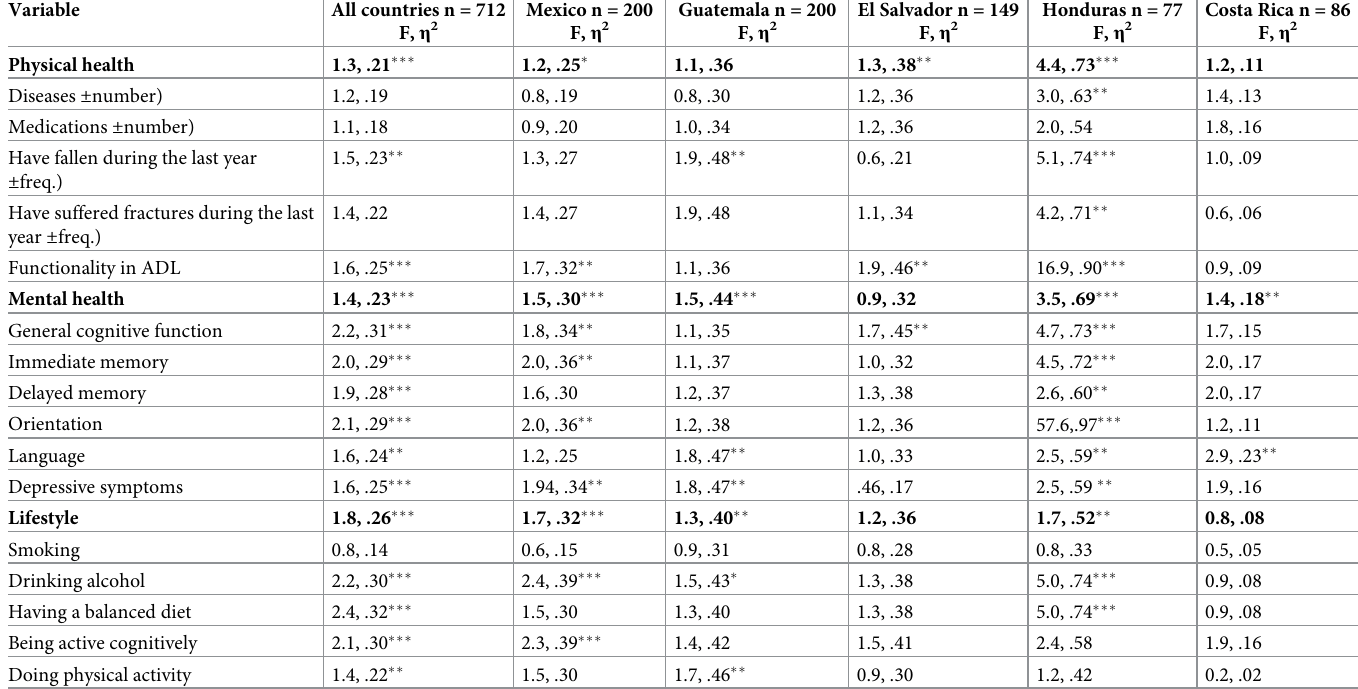
Table 3. Effect size of days in quarantine on physical health, mental health and lifestyle in older adults from Centro American countries during pandemic due to